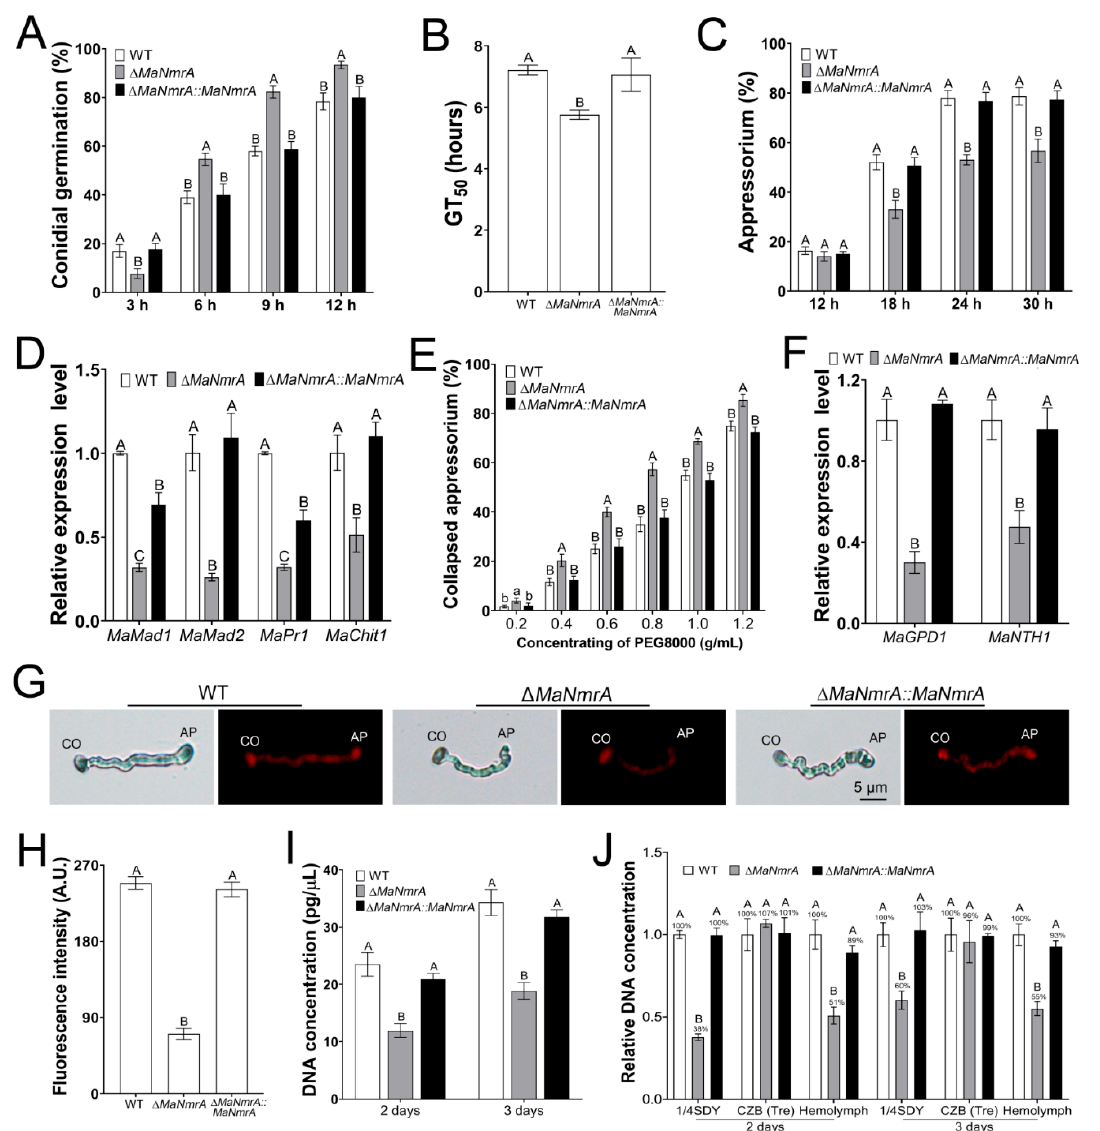
Figure 7. Deletion of MaNmrA affected appressorium development and the growth of the hyphal bodies. The conidial germination ( A ), GT 50 s ( B ), and appressorium formation ( C ) of the WT, ∆ MaNmrA , and ∆ MaNmrA :: MaNmrA strains cultured on locust hind wings at 28°C for different hours. ( D ) qRT-PCR analysis of genes involved in adhesion and cuticle-degrading. ( E ) The appressorium collapsed rates analysis. ( F ) qRT-PCR analysis of genes involved in glycerol synthesis. ( G ) Observation of lipid staining with Nile red. CO, conidium. AP, appressorium. ( H ) Fluorescence intensity measured in ( G ) through ImageJ software. A.U., Arbitrary Units. ( I ) Determination of the DNA concentrations of the fungal strains cultured in the hemolymph of locusts for 2 and 3 days. ( J ) Determination of the DNA concentrations of the fungal strains respectively cultured in complete medium 1 / 4 SDY, modified CZB (Tre), and locust hemolymph. CZB (Tre), CZB with 88 mM trehalose as the single carbon source. Fungal samples used for qRT-PCR analysis were incubated on locust hind wings for 24 h. Letters A, B, a and b above graph were used to shown the significant difference. a and b, p < 0.05. A, B and C, p < 0.01 (Tukey’s